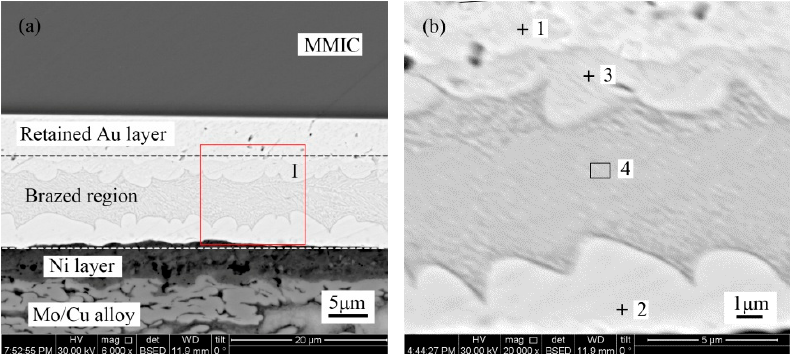
Figure 3. ( a ) Microstructure of the TiW/Au|Au-Sn eutectic joint and ( b ) region I in higher magnification. Table 2. Chemical composition of each region in the TiW/Au|Au-Sn eutectic joint. Position Element Composition (at.%)